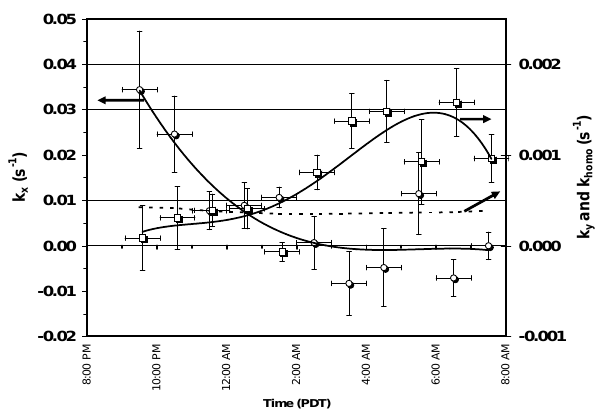
Fig. 9. Nocturnal variation of overall first order rate constants for loss of NO 3 , k x (open circles) and N 2 O 5 , k y (open squares), pre- dicted by fitting hourly binned data to Eq. (13). The dashed line represents k homo , the pseudo first order rate constant for the homo- geneous reaction of N 2 O 5 with H 2 O vapor (see text). Solid lines are 4th order polynomials meant to show the general trend only. Error bars show the standard error of the fit